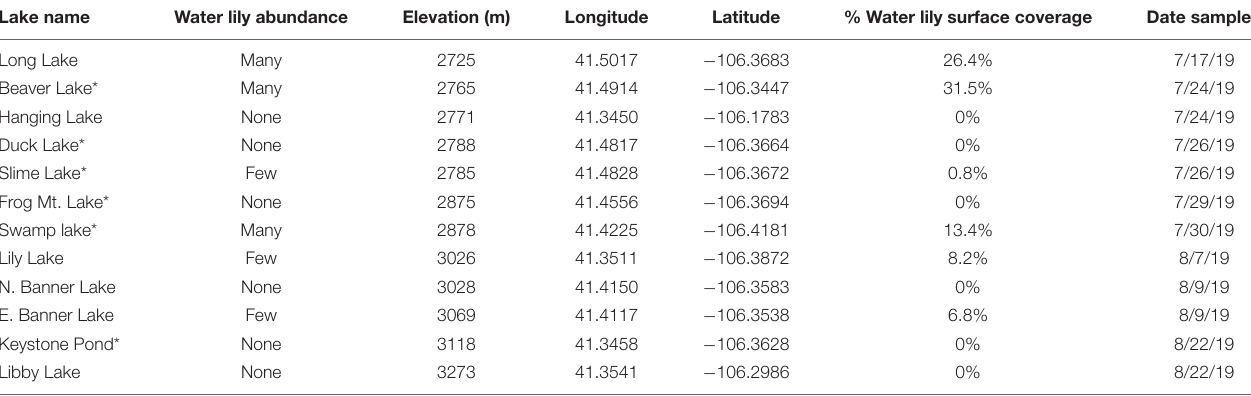
TABLE 1 | Details regarding the mountain lakes that were